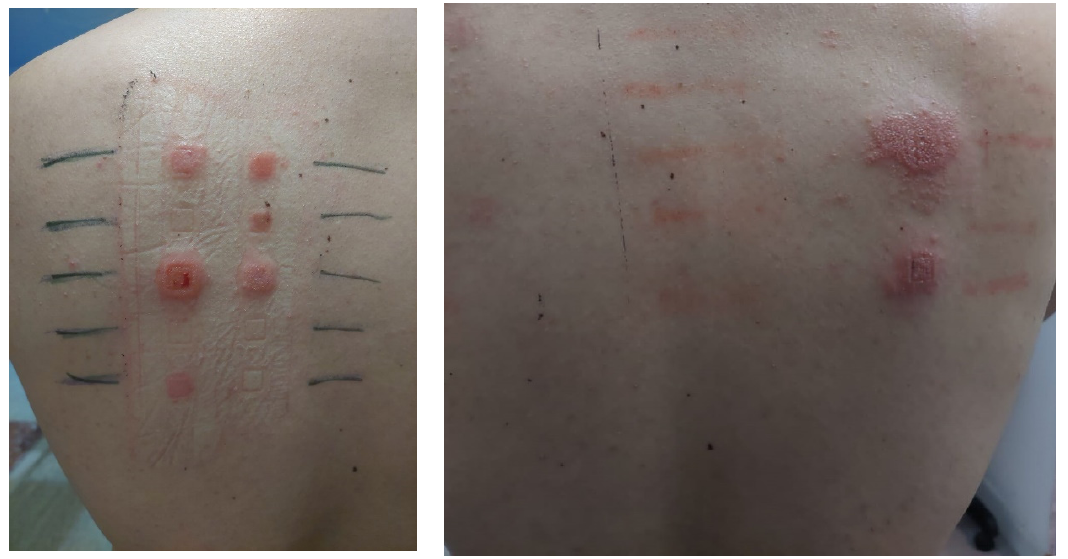
Figure 2. Positive patch tests in a 35-year-old hairdresser.